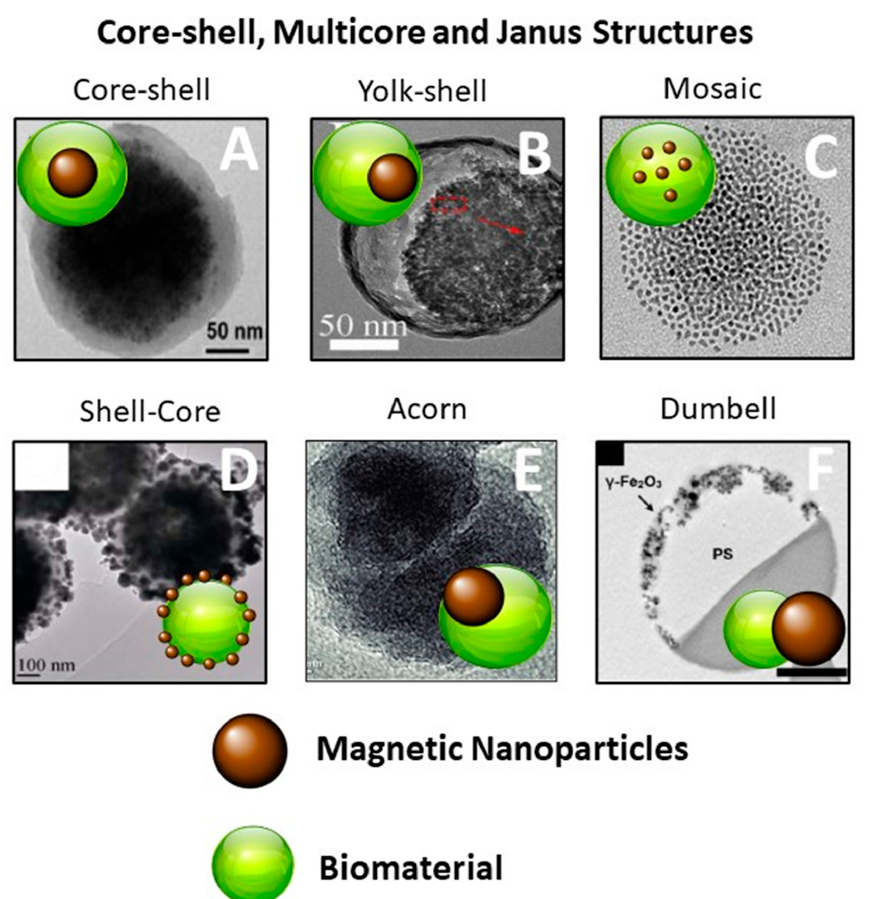
Figure 1. Distinct structures of magnetic bionanocomposites: ( A ) core-shell Fe 3 O 4 polydopamine nanoparticles (Fe 3 O 4 @PDA NPs) (reproduced with permission from ref. [45]. Copyright 2017 El- sevier); ( B ) Polydopamine@upconversion nanoparticle@mesoporous silica yolk-shell nanoparticles (PDA@UCNP@mSiO 2 NPs) (reproduced with permission from ref. [46]. Copyright 2020 Elsevier); ( C ) Mosaic Fe 3 O 4 polydopamine nanoparticles; ( D ) Au speckled SPION@SiO 2 NPs (reproduced with permission from ref. [33]. Copyright 2020 John Wiley and Sons); ( E ) Polyethylene glycol (PEG) stabi- lized MnFe 2 O 4 @MnO Janus nanoparticles (reproduced with permission from ref. [48]. Copyright 2003 Royal Society of Chemistry); ( F ) Polymer-stabilized ferromagnetic γ -Fe 2 O 3 dumbell nanoparticles (reproduced with permission from ref. [49]. Copyright 2013 ACS